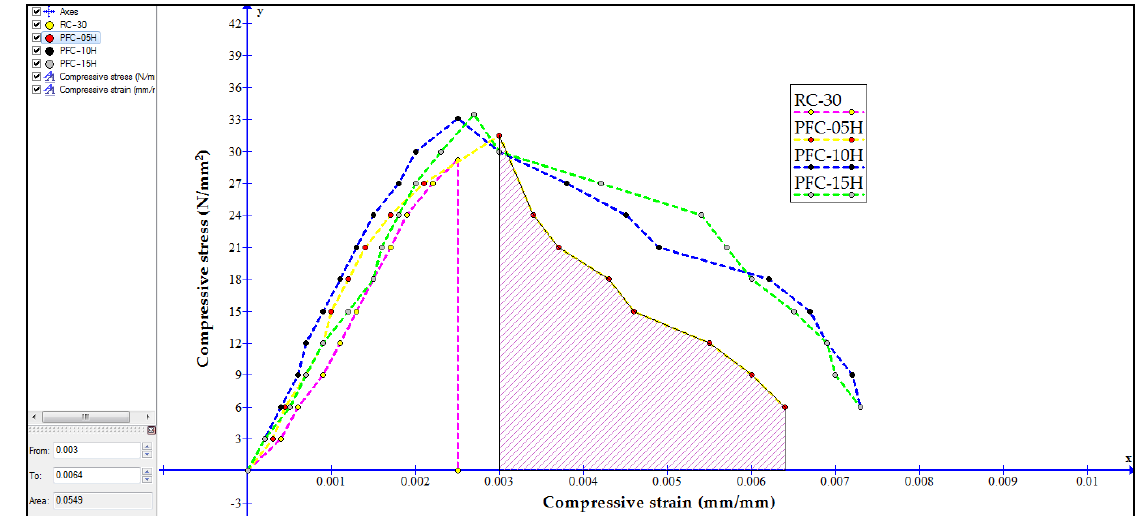
Figure 10. Post ultimate compressive toughness calculation using a graph (shaded area) for various fiber concretes.